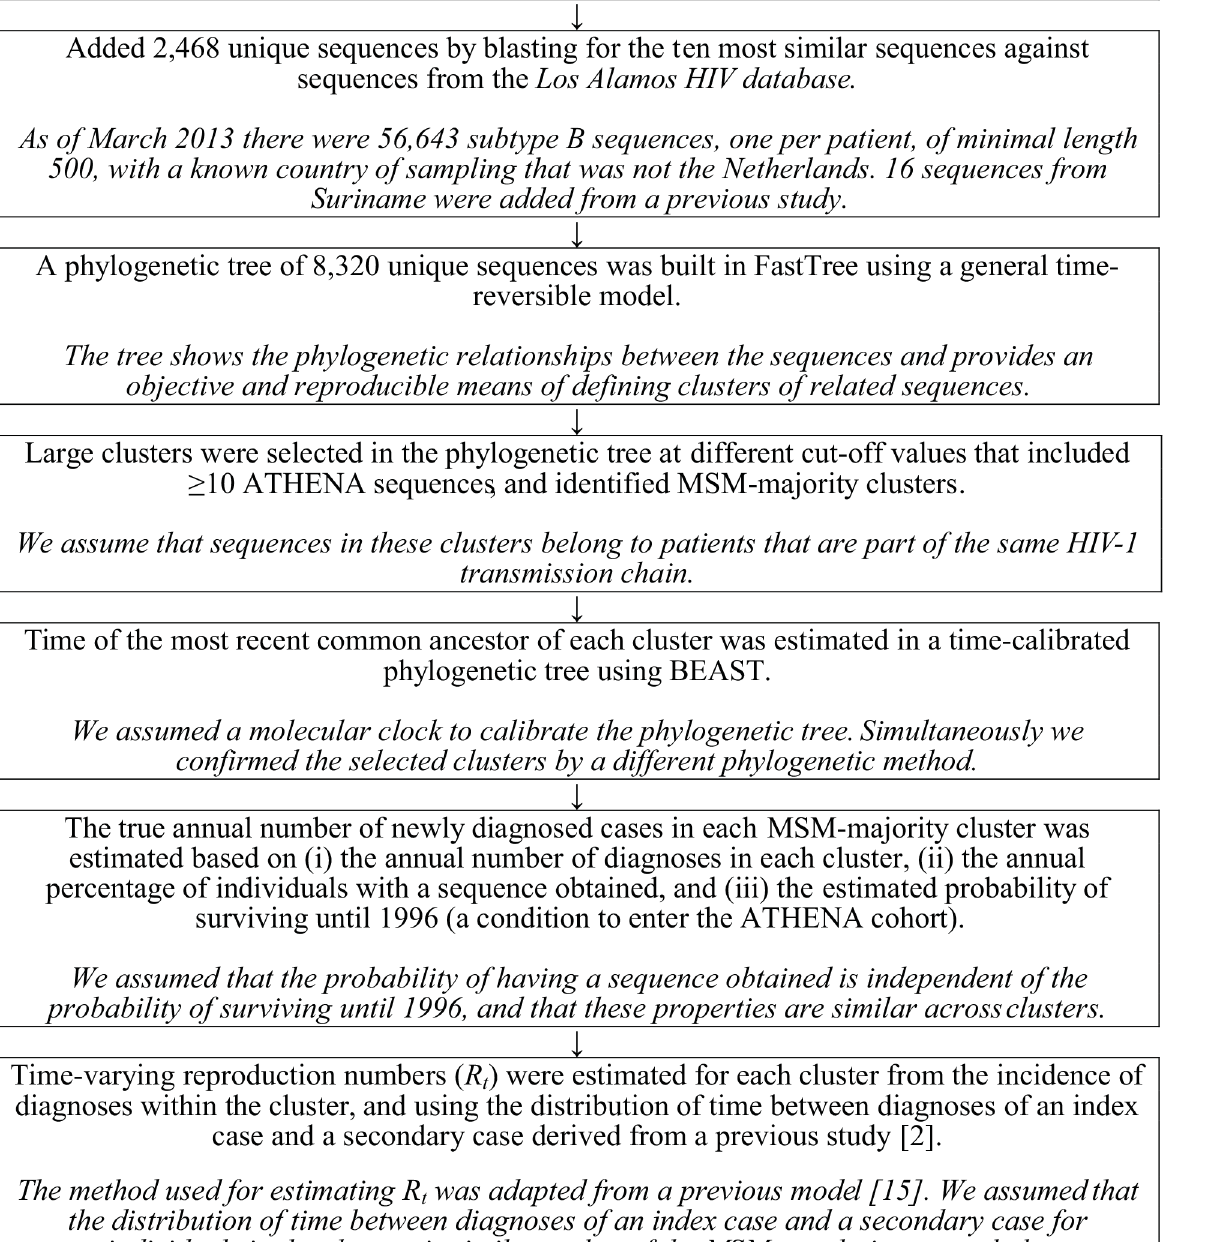
PLOS Medicine | DOI:10.1371/journal.pmed.1001898 November 3,